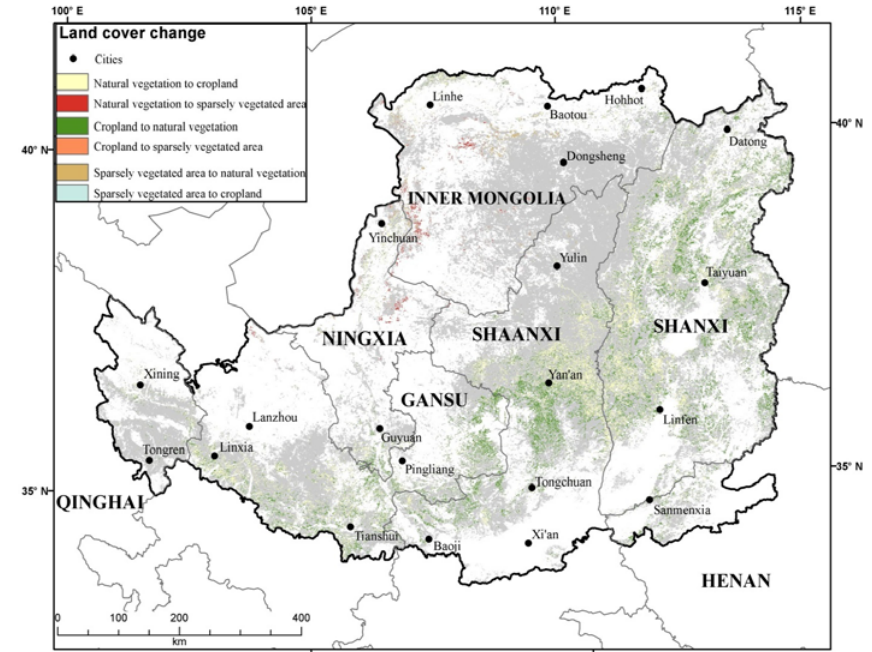
Figure 4. Land cover change within the positive vegetation change region of the Loess Plateau between 2003–2005 and 2006–2008. The land cover change analysis was conducted among three broad land cover categories: natural vegetation, cropland and barren or sparsely vegetated area. Between 2003–2005 and 2006–2008, there was 4.1% and 6.2% increase in natural vegetation and sparsely vegetated area within the positive vegetation change region, respectively. A 10.6% decrease in cropland area was also